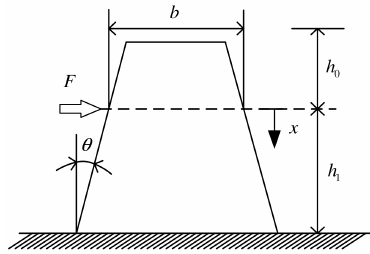
Figure 12. Scheme of the tooth